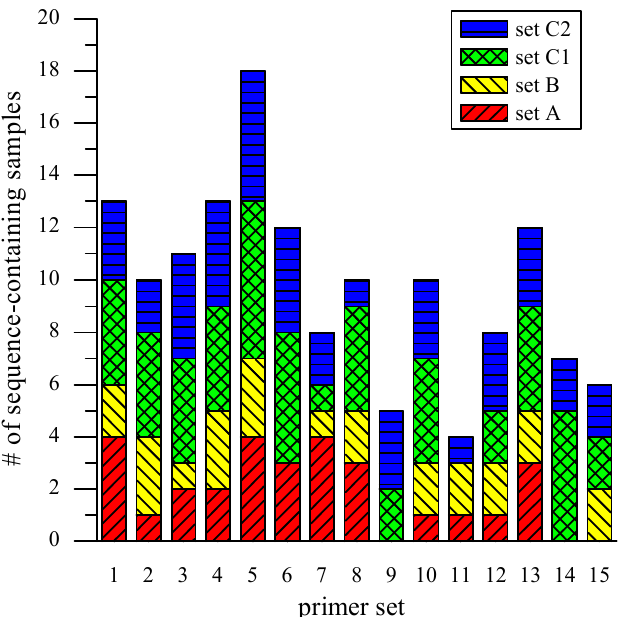
Figure 5. Loci coverage across scMDA samples. The bar chart presents the occurrence of Synechocystis -specific sequences across scMDA samples, broken down by sample and primer